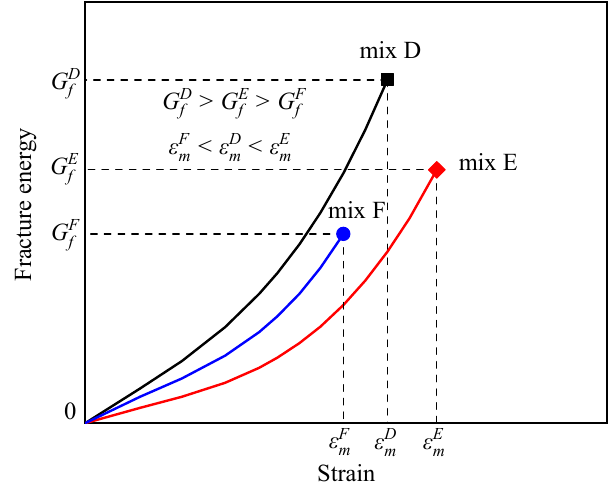
Figure 3. Schematic of FE and failure strain.